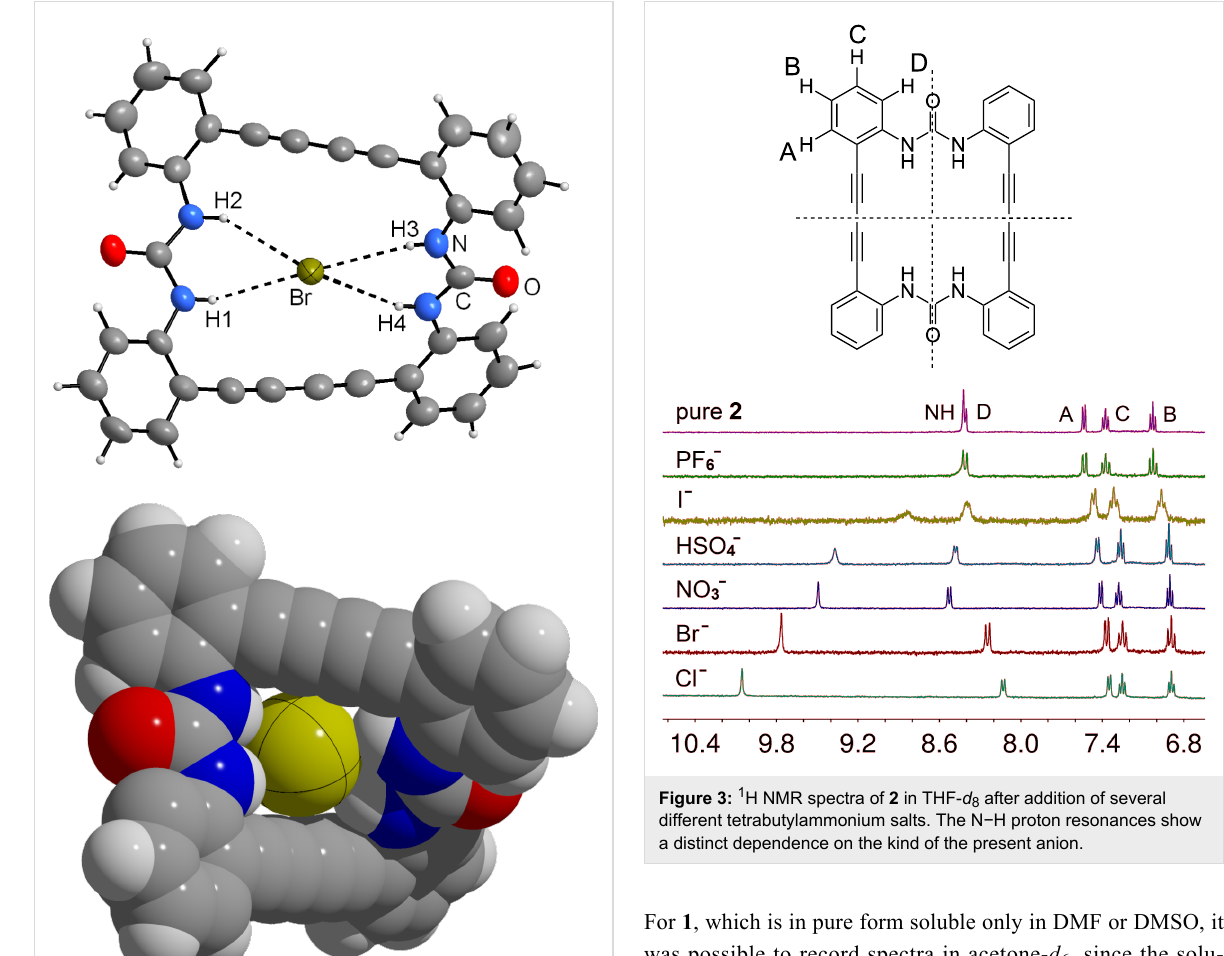
phenyl proton resonances are also affected by the effect. The protons at positions A, B, C (see Figure 3) are shifted slightly upfield, while the phenyl protons in position D ortho to the urea with HSO 4 − and NO 3 − but upfield for the stronger complexes formed with Br − and Cl − . The effect on the phenyl protons amounts to maximally 0.3 ppm and is much weaker than the effect on the urea protons where shifts up to 1.7 ppm are